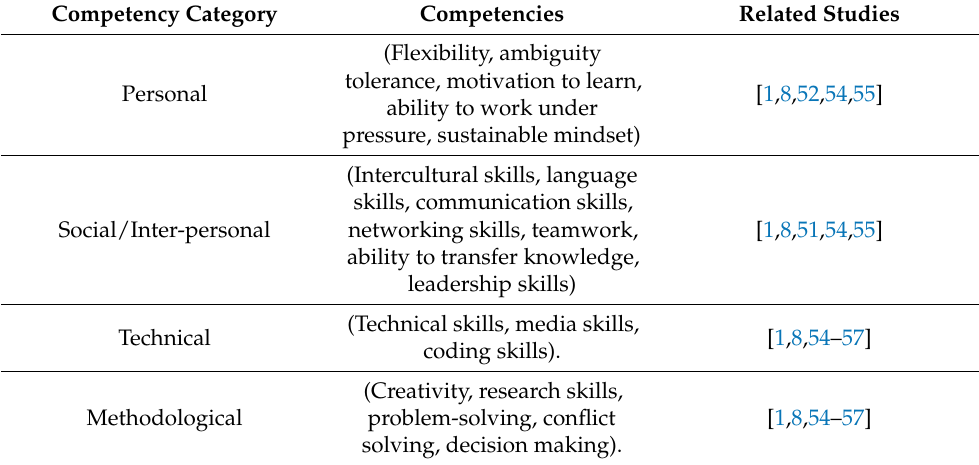
Table 2. A model for Industry 4.0 competences.